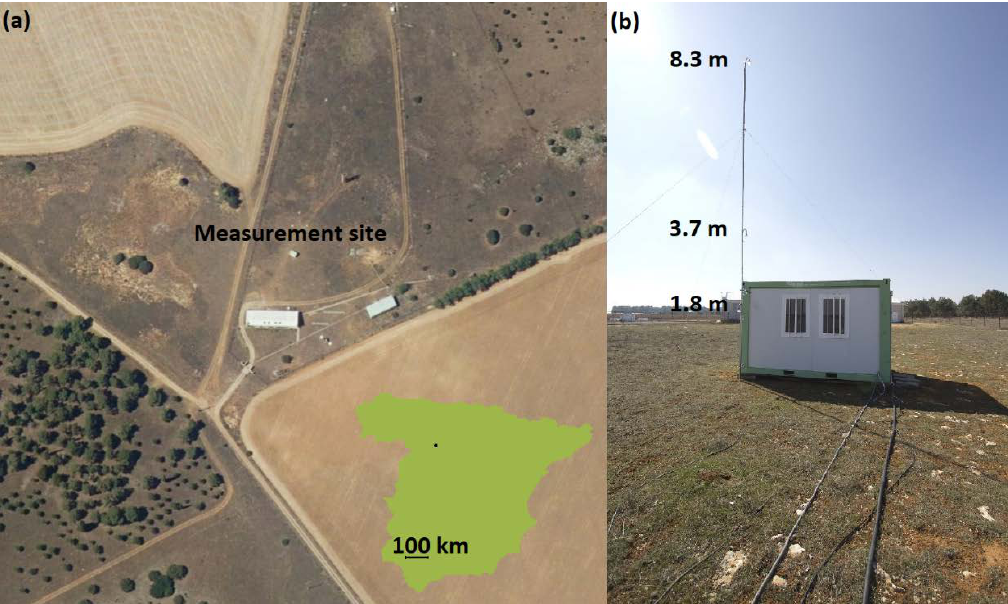
Figure 1. ( a ) PNOA (National Plan of Aerial Orthophotography) image courtesy of © ign.es showing the measurement site together with its location in Spain. ( b ) Analyser housing and measurement heights.